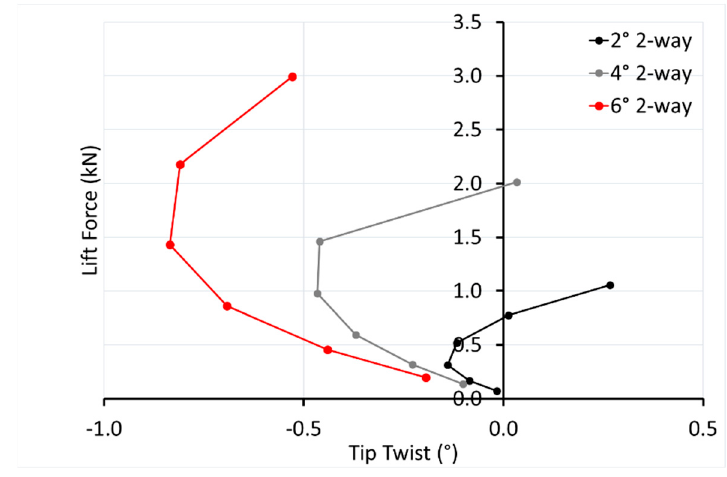
Figure 10. Lift force vs. tip twist.